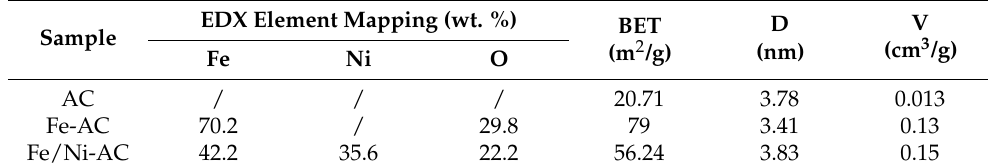
Figure 1. SEM images of the as-prepared samples: ( a ) AC, ( b ) Fe-AC, and ( c ) Fe/Ni-AC.